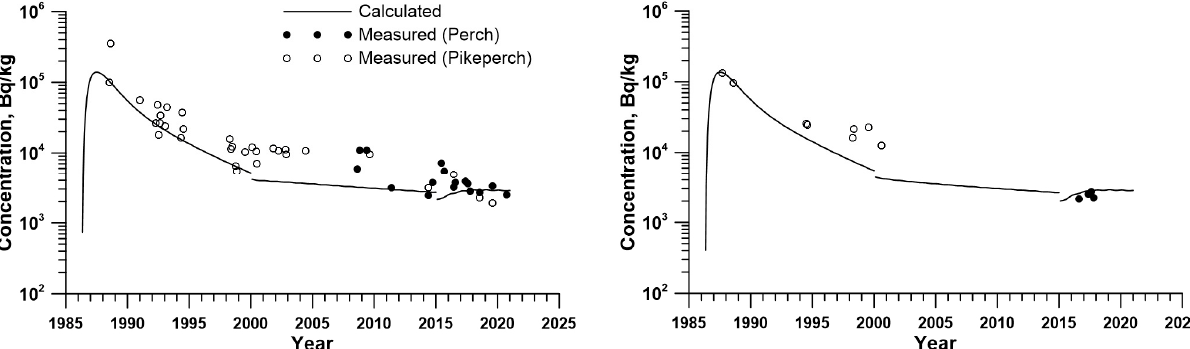
Figure 5. Comparison of calculated and measured concentrations of 137 Cs in coastal predator in Sector 1 ( left ) and Sector 7 ( right ) of the CP.